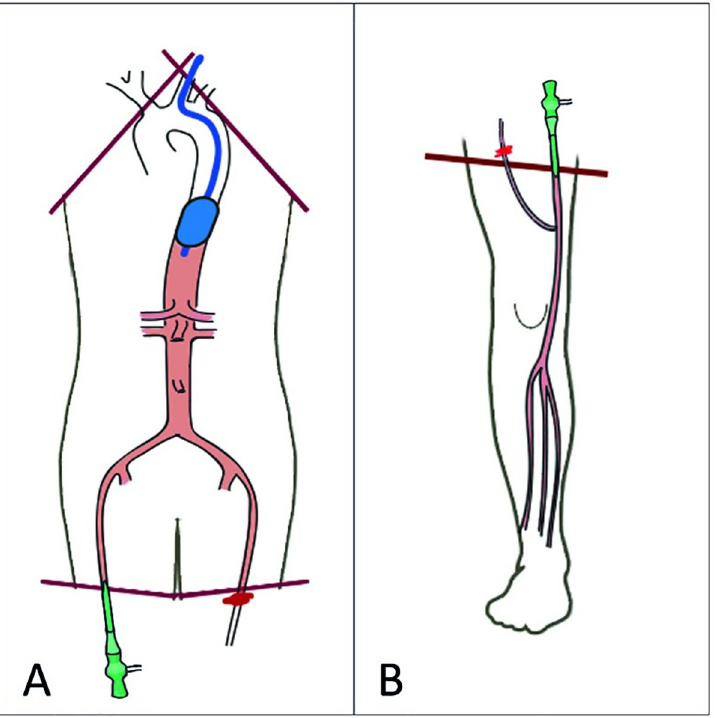
Fig 1. Schematic overview of the torso (A) and lower extremity (B) including dissection planes of the cadaveric specimen. Red lines indicate the dissection planes. The access sheath is indicated in green. Fluid leakage is prevented by ligation of the main collateral arteries in the dissection plane, and, in the torsos, by balloon occlusion of the proximal aorta and ligation of the contralateral femoral artery.